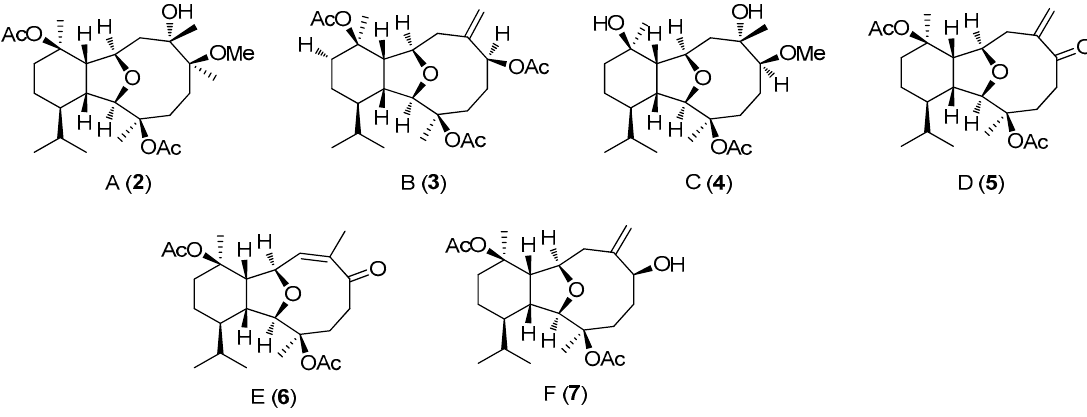
Figure 4. Palmonines A–F ( 2 – 7 ) isolated by Ortega’s group.